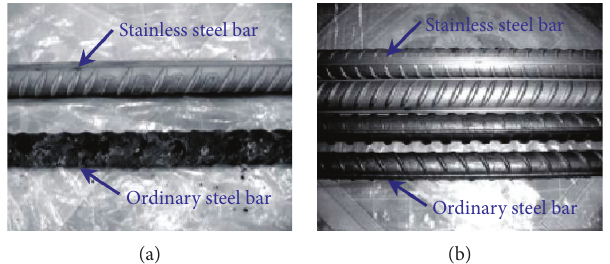
Figure 3: Comparison of the corrosion of stainless steel bars and ordinary steel bars: (a) before rust removal and (b) after rust removal.